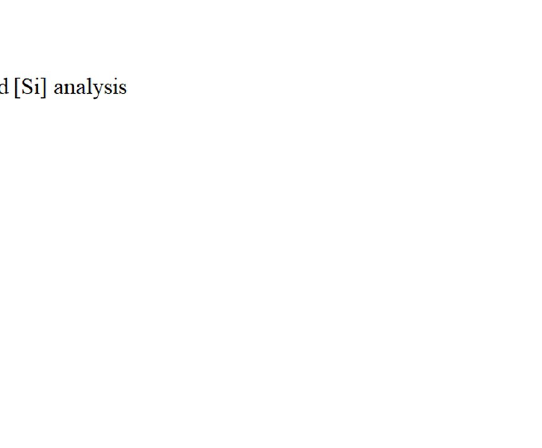
Table 3. Sample number with regard to different slag and reaction time.